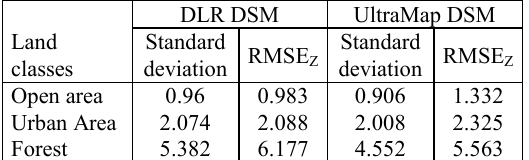
Table 1. Standard deviations and (RMSE) of differences for selected areas